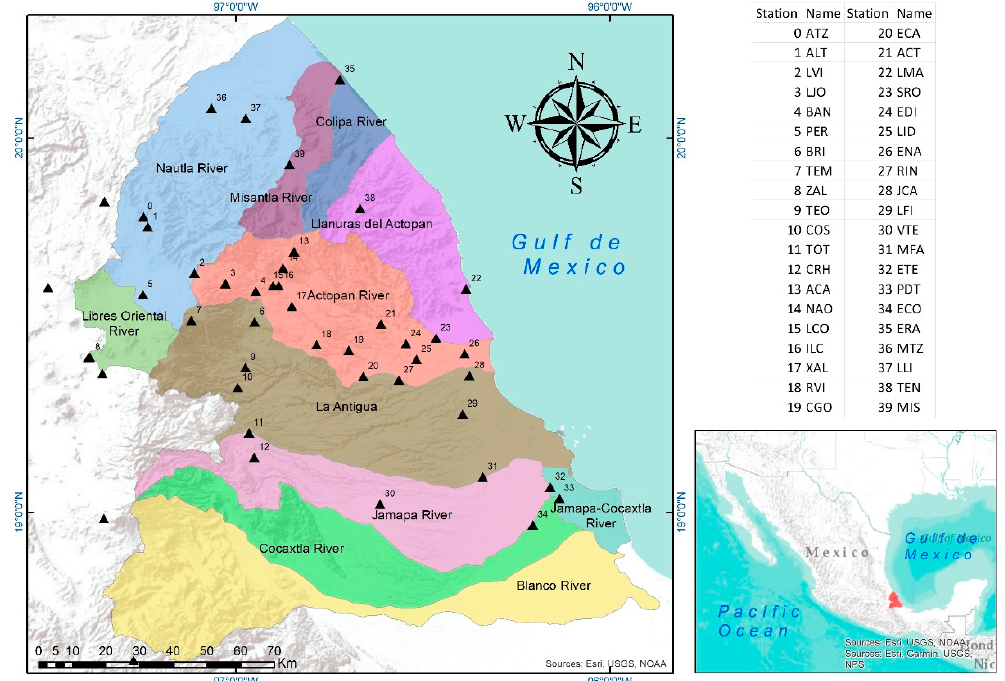
Figure 1. Study area with its hydrological basins in different colors. The black triangles represent the weather stations used for this study [38]. The number and code of the meteorological stations are indicated in the above grid. Sources: Map modified from data obtained in the SMN (National Meteorological Service of Mexico) [42], INEGI (National Insititure of Statistics and Geography of Mexico) [38], ESRI (Environmental Systems Research Institute) [49].